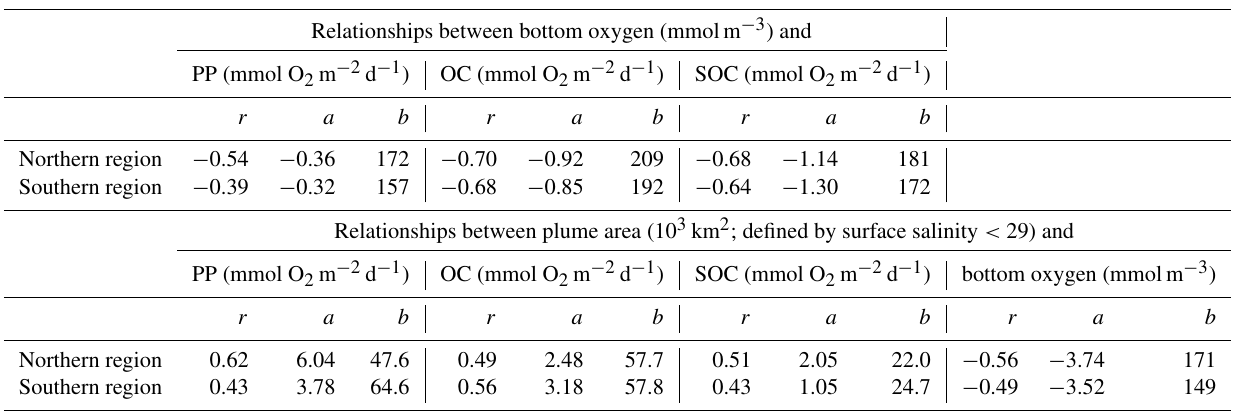
Figure 5. Correlations of time-integrated hypoxic area, average primary production, respiration, and bottom oxygen in the typical low- oxygen zone in August, and the spatial extent of the FW plume (defined here as the area with surface salinity smaller than 29) with annually integrated FW input and DIN load. Correlation coefficients are given for all 6 years and, in italic font, after excluding the year 2011. Significant correlations are shown in bold font, and linear regressions are indicated by the black line where the correlation is significant at p < 0 . 05. Table 1. Correlation coefficients and parameters of a linear model fit (of the form y = ax + b ) between bottom oxygen, FW plume area, PP, OC, and SOC in the northern and southern